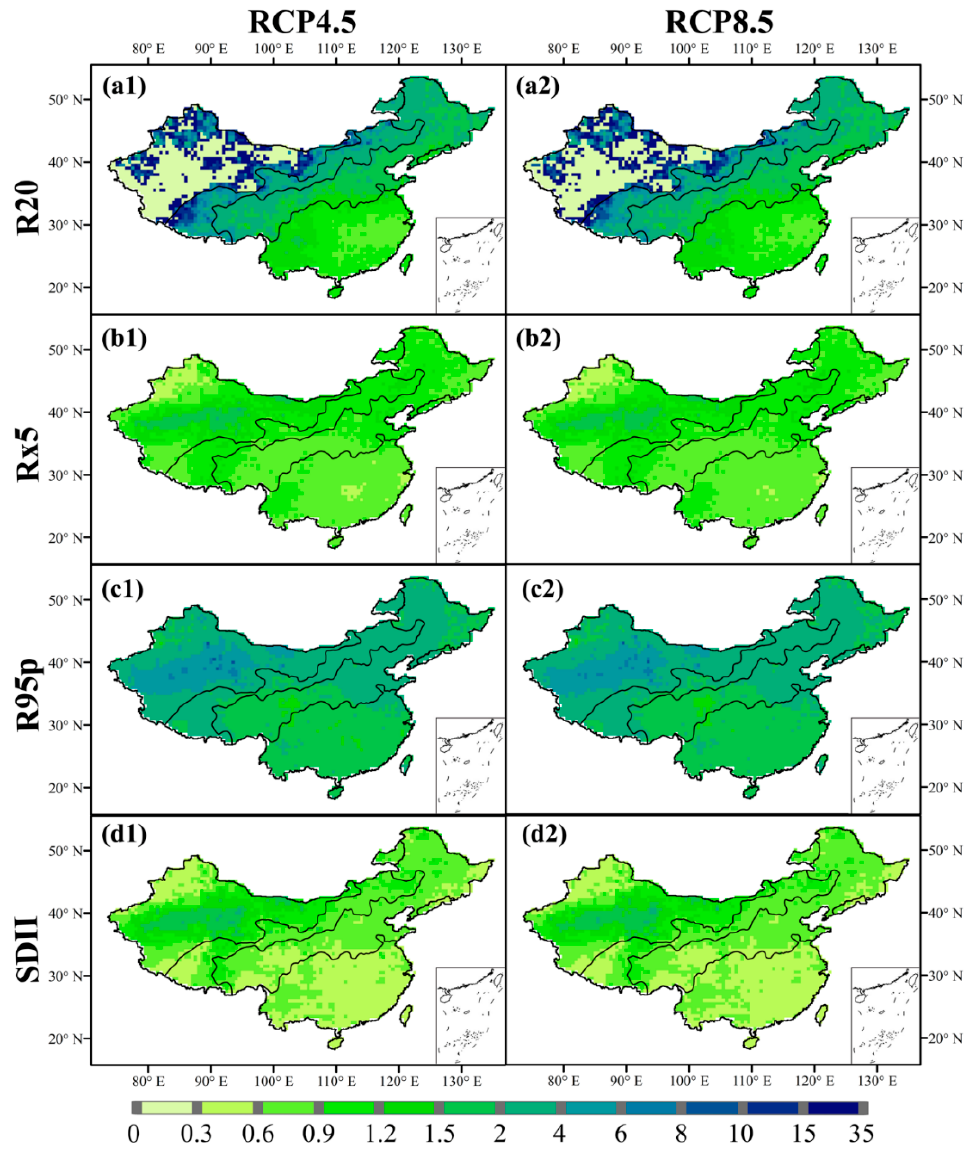
Figure 10. Extreme precipitation difference coefficients ( C ) in four regions under two scenarios (RCP4.5 and RCP8.5) in 2006–2099. There are four precipitation indices. R20 index: ( a1 , 2 ); Rx5 index: ( b1 , 2 ); R95p index: ( c1 , 2 ); SDII index: ( d1 , 2 ).